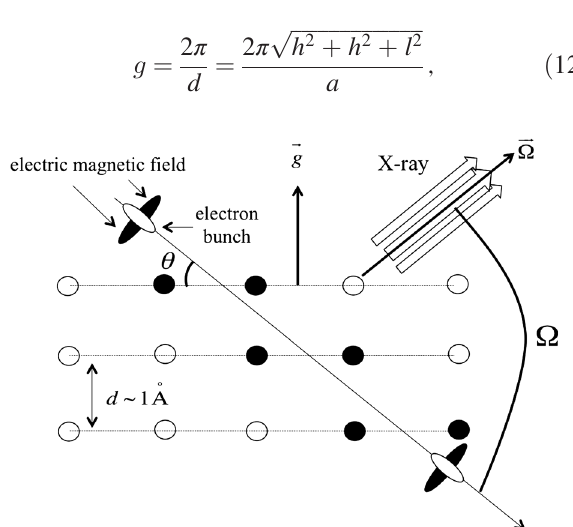
ffiffiffiffiffiffiffiffiffiffiffiffiffi p 1 − C 2